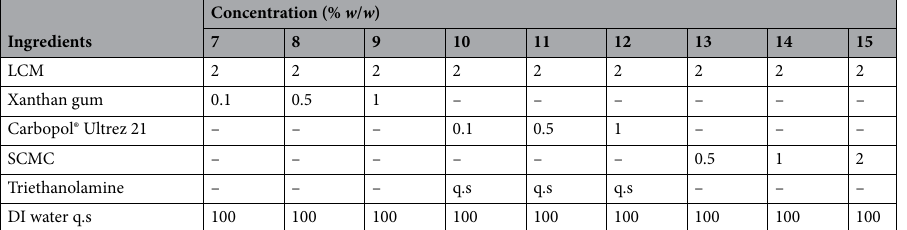
Table 6. Formulations of LLCs using different types and concentrations of thickening agents. LCM: Liquid Crystal Cream Maker (sorbitan stearate and sucrose cocoate); Carbopol® Ultrez 21: acrylates/C10–30 alkyl acrylate cross-polymer; SCMC: sodium carboxymethylcellulose. Formulations 7–9 used xanthan gum at concentrations ranging from 0.1 to 1% w / w , Formulations 10–12 used Carbopol® Ultrez 21 at concentrations ranging from 0.1 to 1% w / w , and Formulations 13–15 used SCMC at concentrations ranging from 0.1 to 1% w /